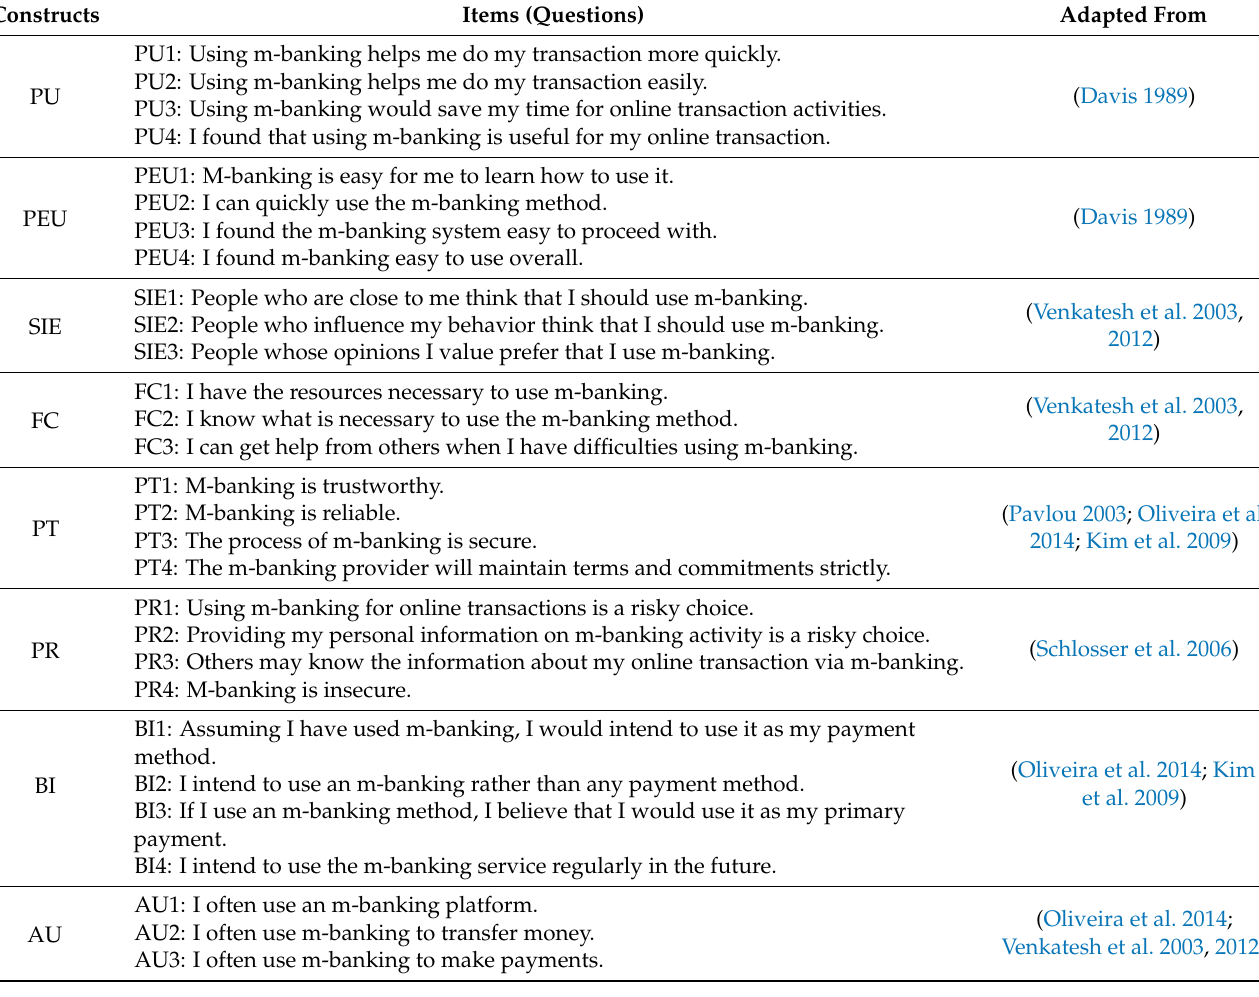
Table A1. Questions used in the questionnaire survey.